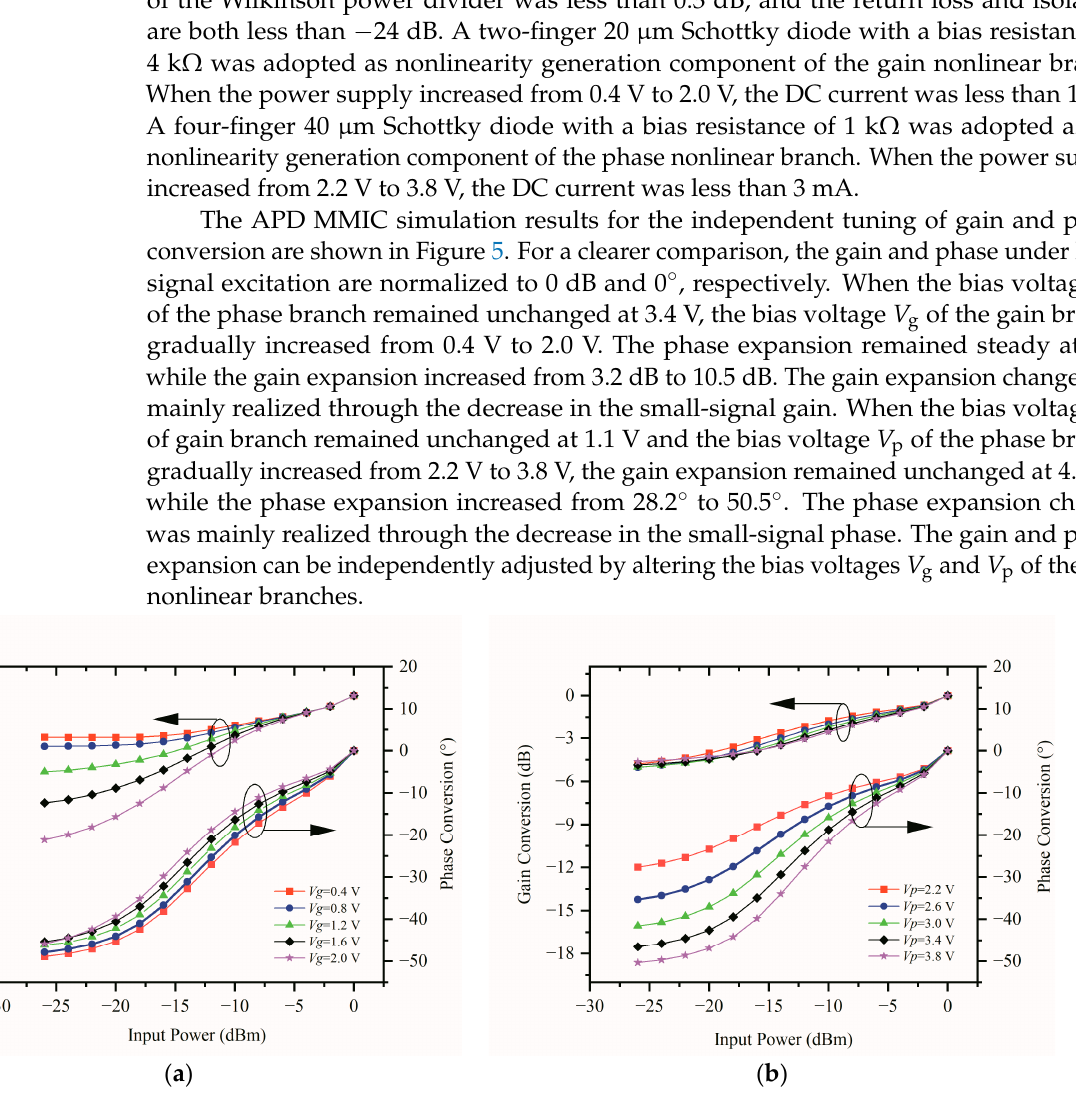
Figure 5. Simulated results of the independent tuning of ( a ) gain conversion and ( b ) phase conver-